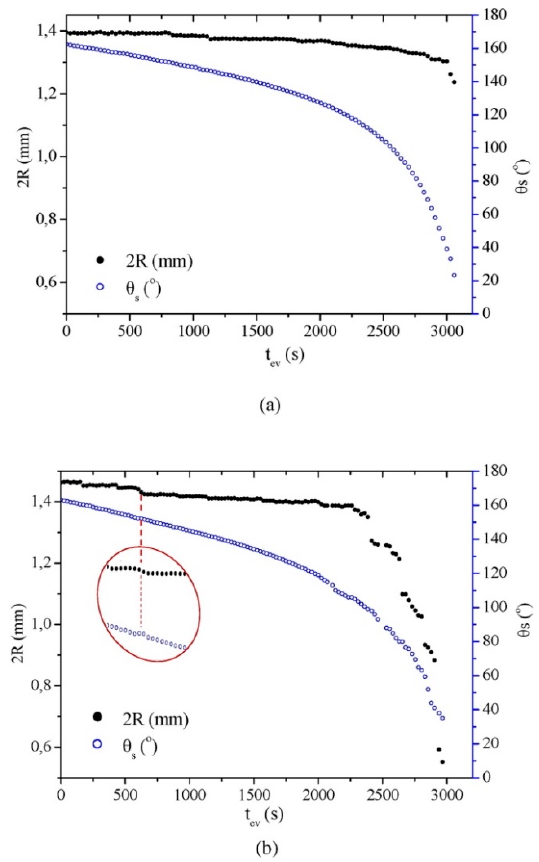
Figure 7. Contact angle ( θ S ) and contact diameter (2R) of water drops on treated ( a ) marble and ( b ) sandstone surfaces vs. evaporation time (t ev ). Marble and sandstone were coated with the emulsion siloxane +2% w /w SiO 2 . In ( b ), the results recorded at a depinning point of the contact line are magnified to clearly demonstrate the decrease in R and the slight temporary increase in θ S . Reprinted with permission from [88], Copyright (2016) Elsevier.